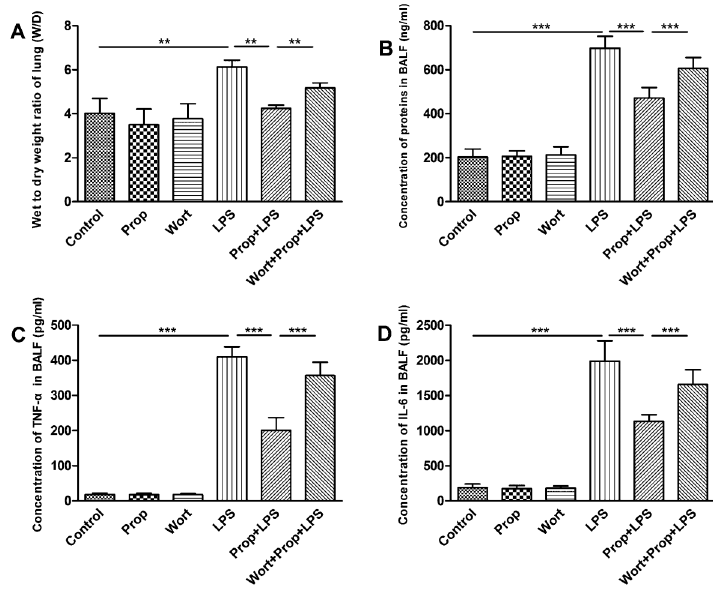
Figure 2. The lung wet to dry weight (W/D) ratio, and concentration of proteins, TNF- a and IL-6 in bronchoalveolar lavage fluid (BALF). Data are reported as means±SD for n=8 animals per group. Data are representative of triplicate experiments with similar results. TNF- a : tumor necrosis factor- a ; IL-6: interleukin-6; LPS: lipopolysaccharide; Prop: propofol;